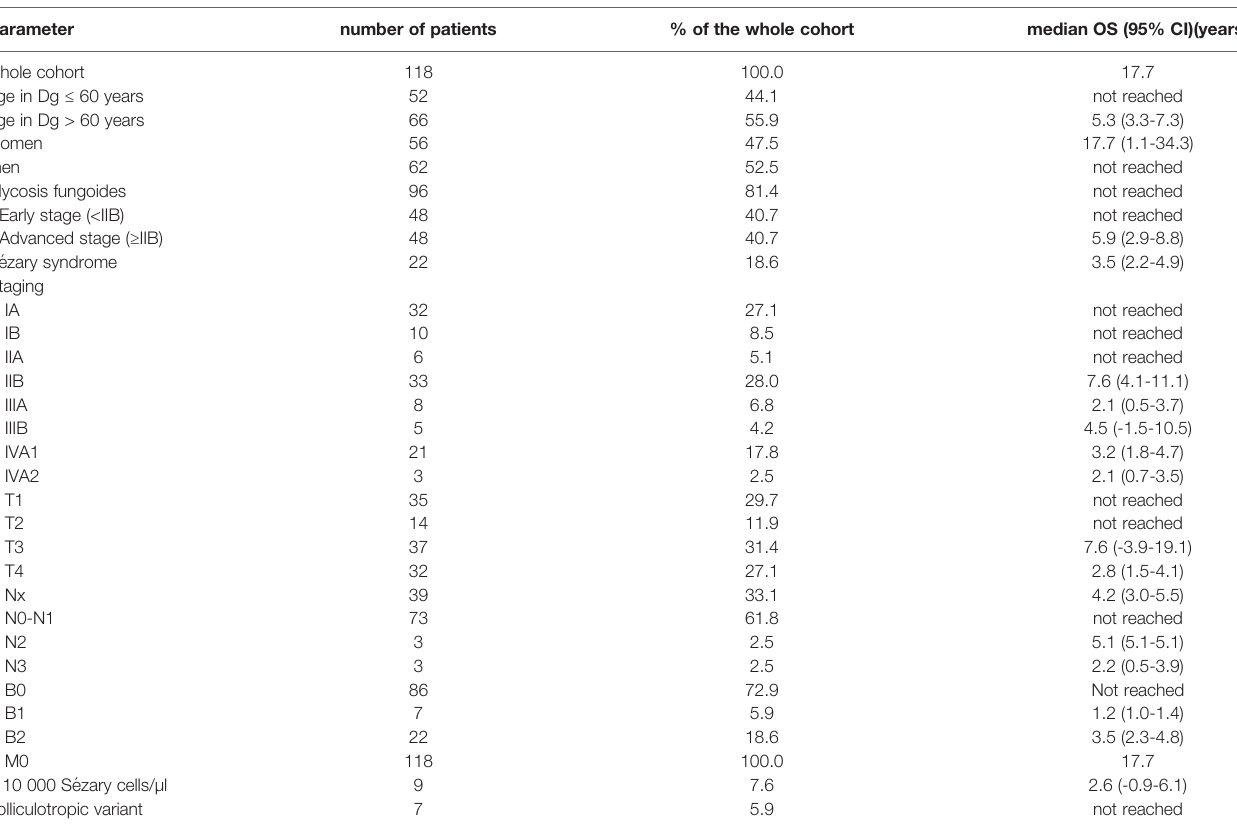
TABLE 1 | Summary of demographic, clinical staging characteristics, prognostic factors, and OS of the analyzed patients. Parameter number of